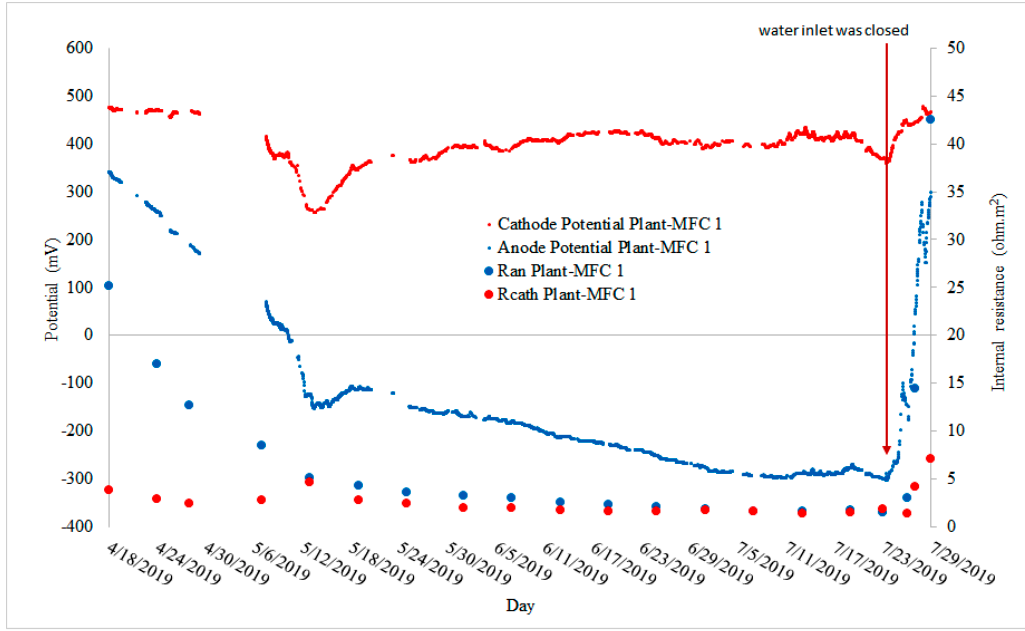
Figure 7. Anode and cathode internal resistance on Plant-MFC 1 during the fourth crop season.